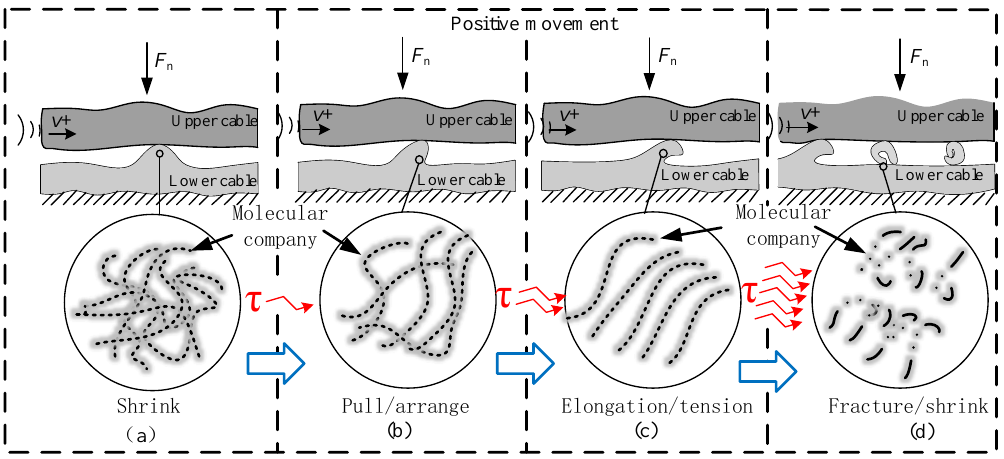
Figure 3. Mechanical force chemical wear principle explanation diagram ( a ) the long chain contraction, ( b ) the long chain stretching, ( c ) the long chains stretch to the limit, ( d ) the long chain break.